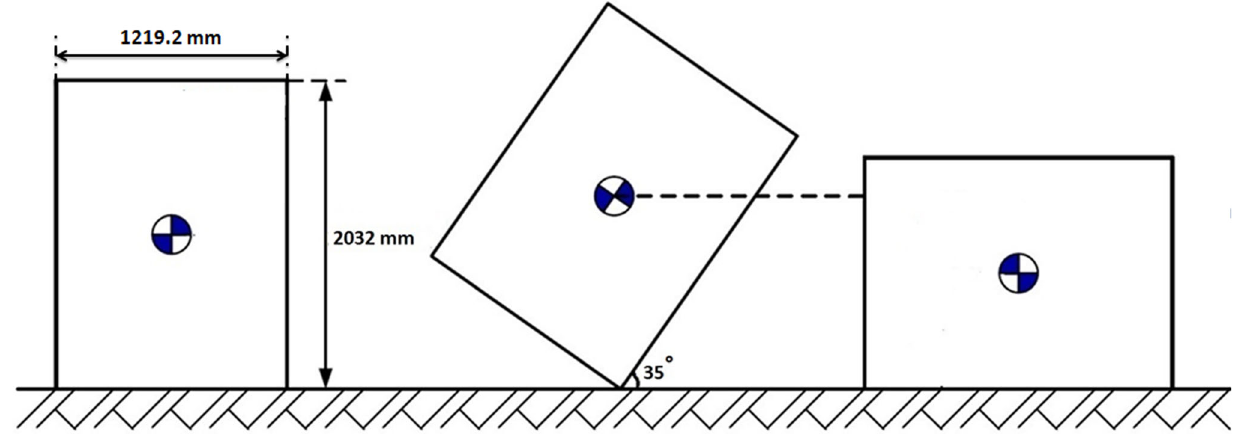
Fig. 13 Positions of the 1/3-scale cask during the tip-over analysis.